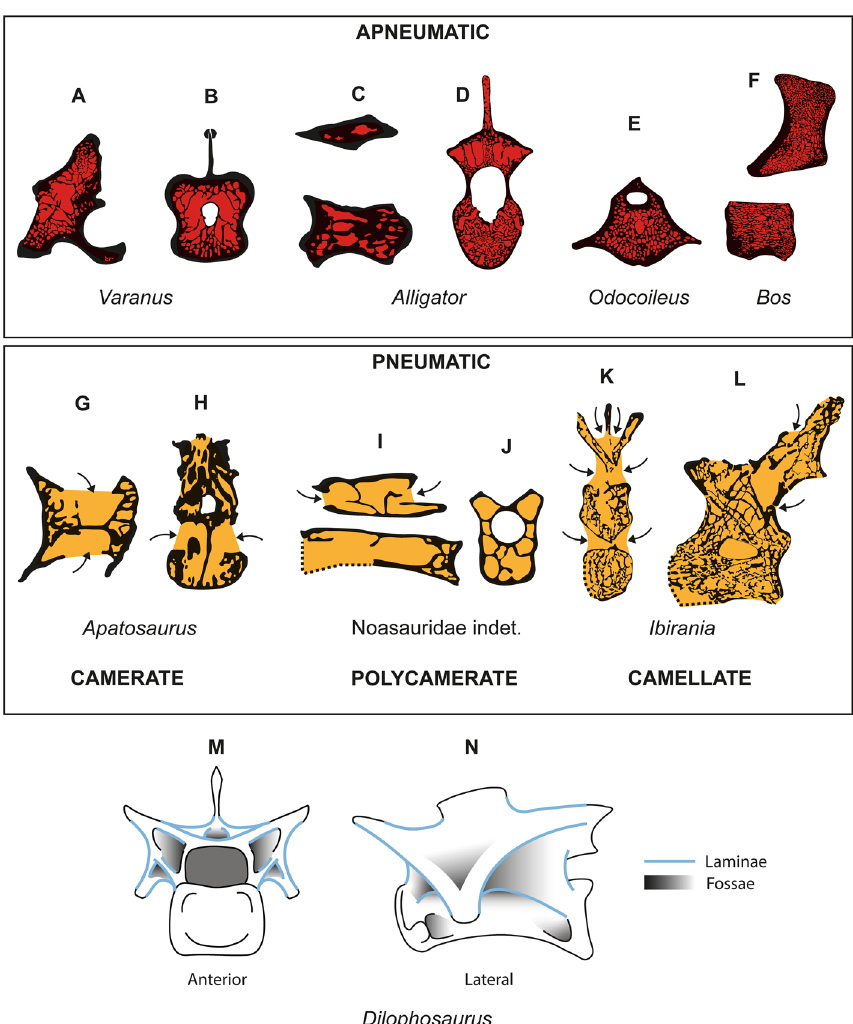
Figure 1. Examples of vertebrae with apneumatic ( A – F ) and pneumatic ( G – L ) architectures, and schematic drawings of vertebral fossae and laminae in ( M and N ). ( A , B ) Varanus komodoensis (NHMUK RR 1934.9.2.2) 15 . ( C , D ) Alligator mississippiensis (OUVC 11415 and NHMUK RR 1975.14.23, respectively). ( E ) Odocoeileus virginianus . ( F ) Bos taurus . ( G , H ) Apatosaurus sp. (MOR 957 6-29-92) 35 . ( I , J ) noasauridae indet. (DGM 929- R) 36 . ( K,L ) Ibirania parva (LPP-PV-0200) 37 . ( M , N ) Dilophosaurus wetherilli 38 . Lateral view in ( A , C , F , I , L , N ). Transverse sections in ( B , D , E , J , K , M ). Ventral view in ( G ). High contrast outlines in A-D and G-L based on CT scan data. ( M and N ) are based on the original schematic drawing of Adam Marsh 38 . WitmerLab at Ohio University provided access to the Alligator data originally appearing on their website, the collection of which was funded by NSF. The file was downloaded from www. Morph oSour ce. org, Duke University. Not to scale. Figures were generated with Adobe Illustrator CC version 22